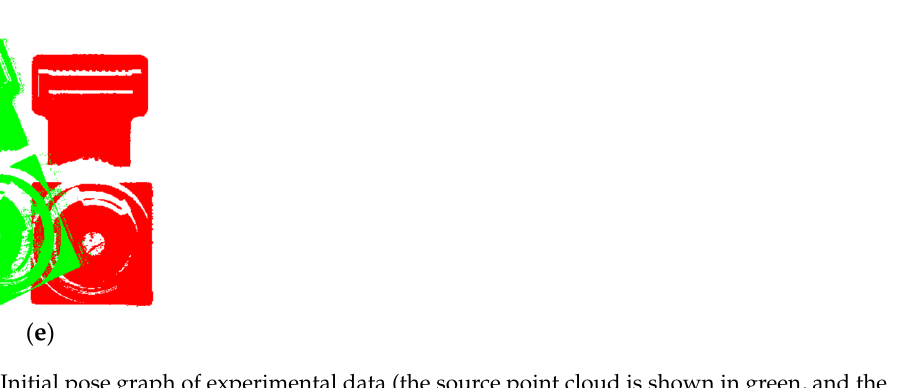
Figure 5. Initial pose graph of experimental data (the source point cloud is shown in green, and the target point cloud is shown in red). ( a ) Happy Buddha data; ( b ) Armadillo data; ( c ) Bunny data; ( d ) Chicken data; ( e ) Camera Module data. Table 1. Data used in the experiment.